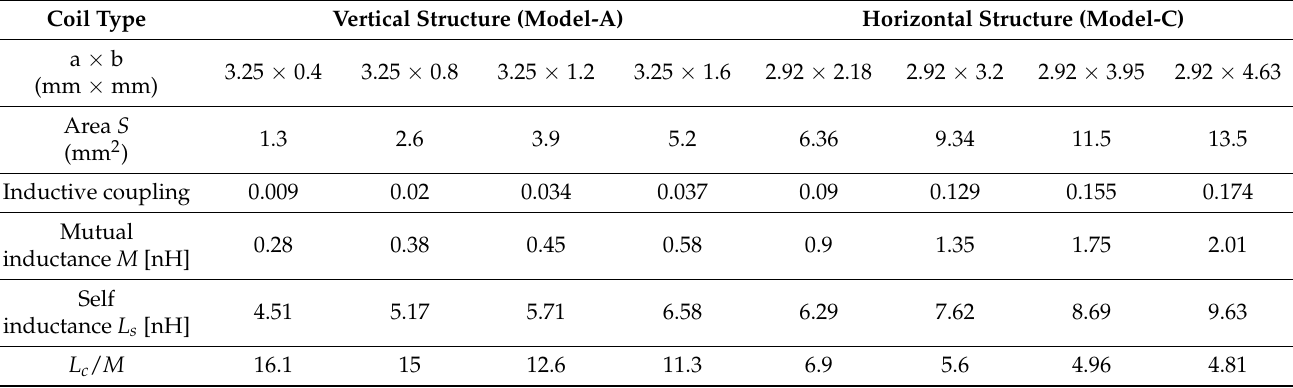
Table 2. Influence of the inductance under different magnetic flux incident areas S with the FEA method.